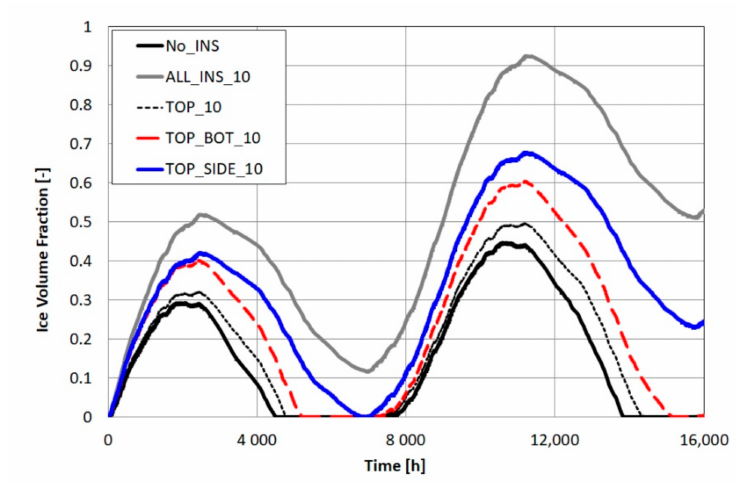
Figure 7. Ice volume fraction over the two-year simulation with cases with 10-cm thick insulation. The same results for 5-cm thick insulation layers are plotted in Figure 8; it is worth underlining that in the TOP_5 case, which exhibits the lowest primary energy consumptions, only less than 50% of the storage volume is frozen during the second year, but this volume is enough to satisfy the cooling loads without any contribution of the HP.